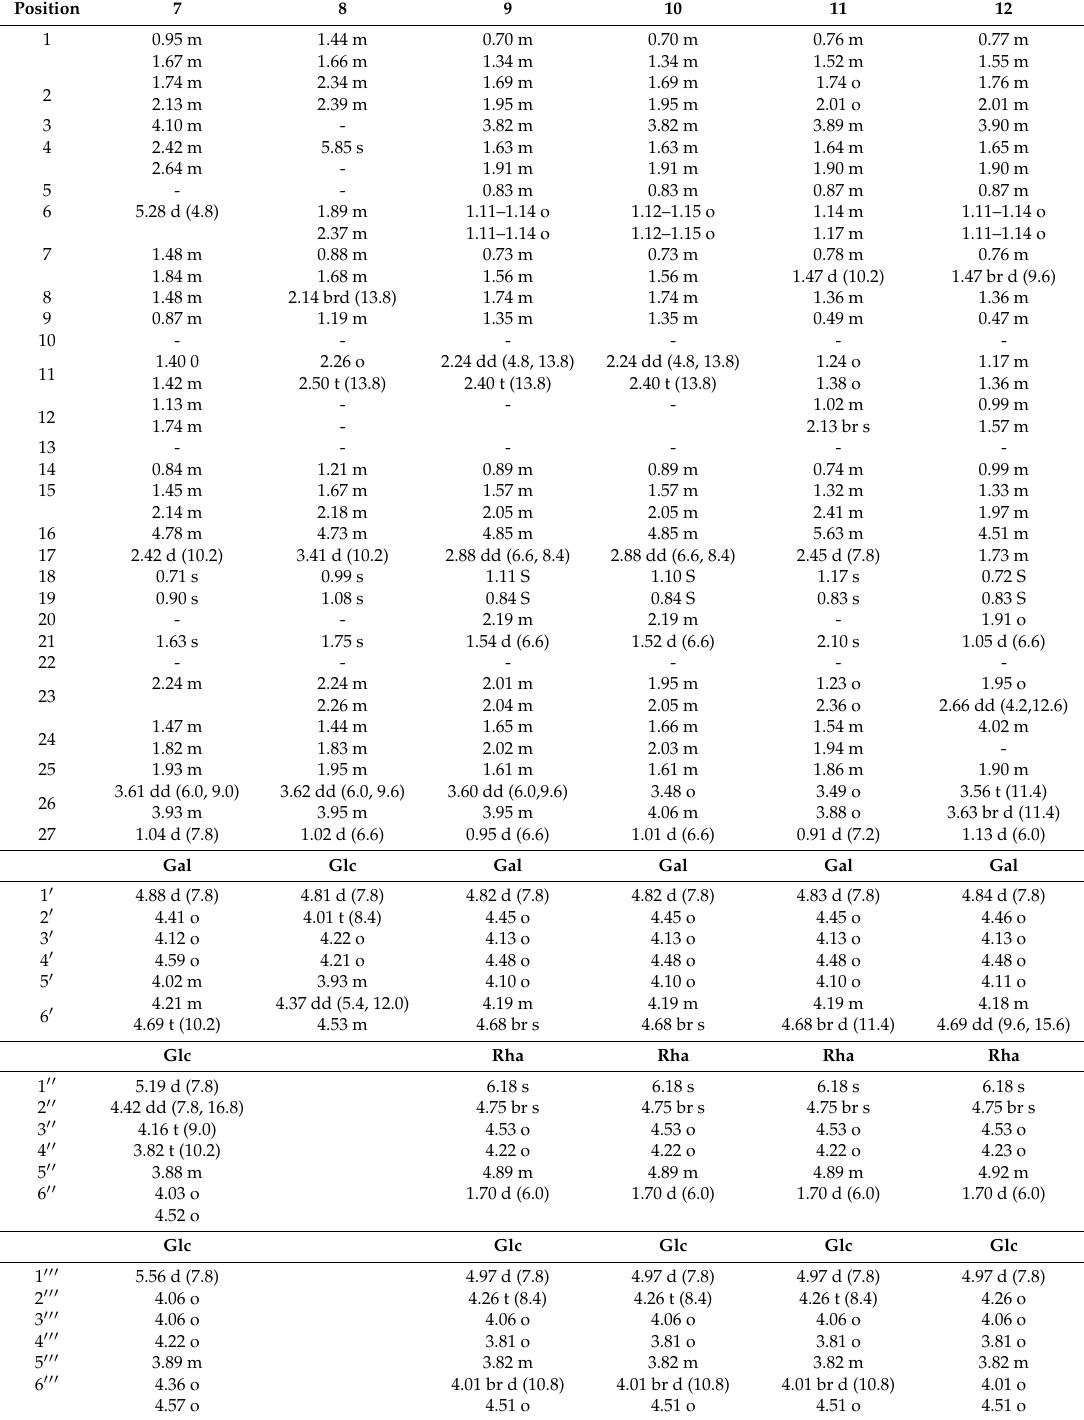
Table 3. 1 H-NMR data ( J in Hz) for compounds 7 – 12 in pyridine- d 5 ( δ in